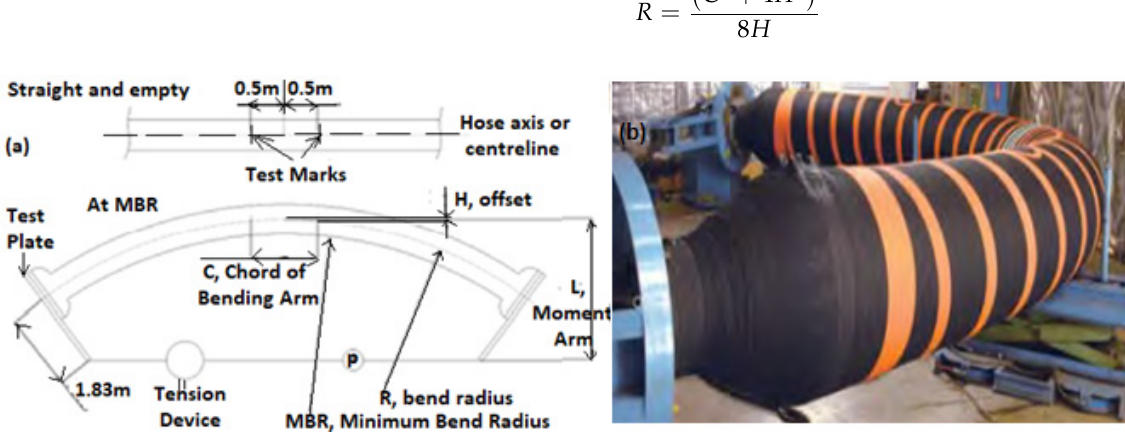
Figure 29. Two setup diagrams for OCIMF Bending Stiffness Test on marine hose, showing (a) the circuit diagram for bending stiffness test, and (b) the typical bending stiffness test on a marine hose.